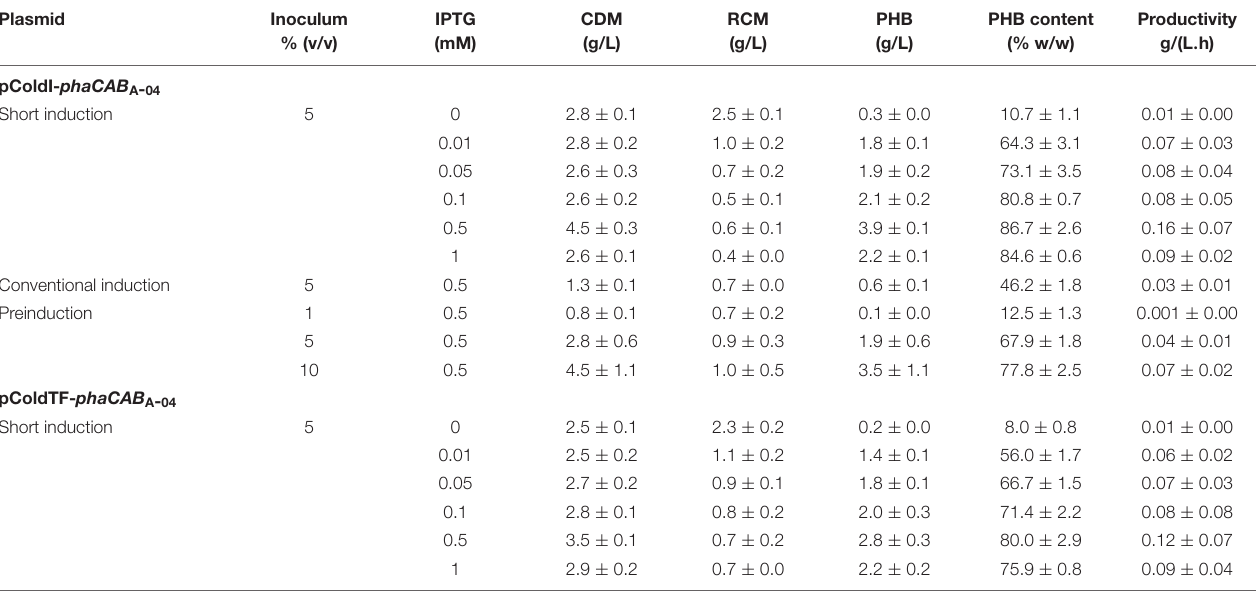
FIGURE 2 | Effect of the growth phase suitable for cold-shock induction on CDM and PHB content (% w/w) under the conventional induction method. The different growth phases were investigated by varying OD 600 based on cultivation time [0.5 (2 h, early exponential phase), 1.3 (4 h, middle exponential phase), 2.1 (6 h, late exponential phase), and 2.4 (10 h, stationary phase)] for (A) E. coli JM109 (pColdI- phaCAB A - 04 ) and (B) E. coli JM109 (pColdTF- phaCAB A - 04 ). A control experiment was performed with 0.0 mM IPTG induction. All the data are representative of the results of three independent experiments and are expressed as the mean values ± standard deviations (SDs). The PhaC A - 04 protein was detected by western blot analysis using anti-His tag antibody as the primary antibody. The band appearing in the western blot at the position corresponding to that of the His-tagged phaC A - 04 protein was 67 kDa in size for pColdI- phaCAB A - 04 , and the fusion protein of His-tagged phaC A - 04 and TF was 115 kDa in size. All the data are representative of the results of three independent experiments and are expressed as the mean values ± standard deviations (SDs). Symbols: open squares, CDM (g/L); closed circle, PHB (g/L). TABLE 2 | Effect of IPTG concentration on CDM (g/L), PHB (g/L), % (w/w) PHB content and PHB productivity in a comparison between E. coli JM109 harboring pColdI-